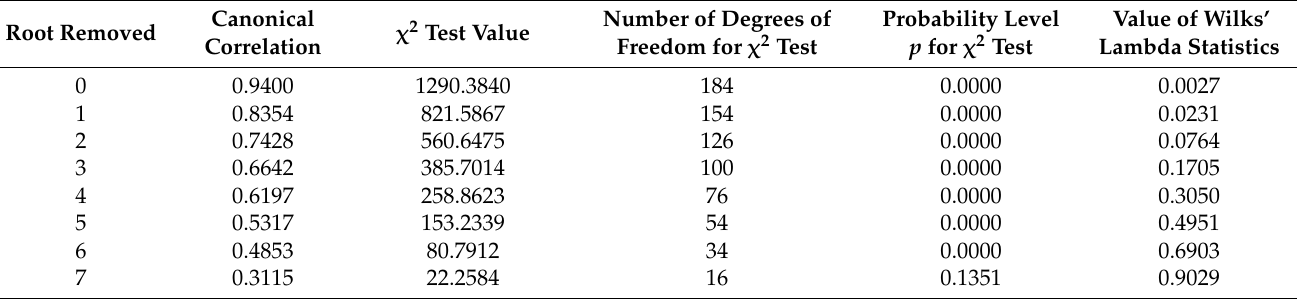
Table 5. Wilks’ lambda test